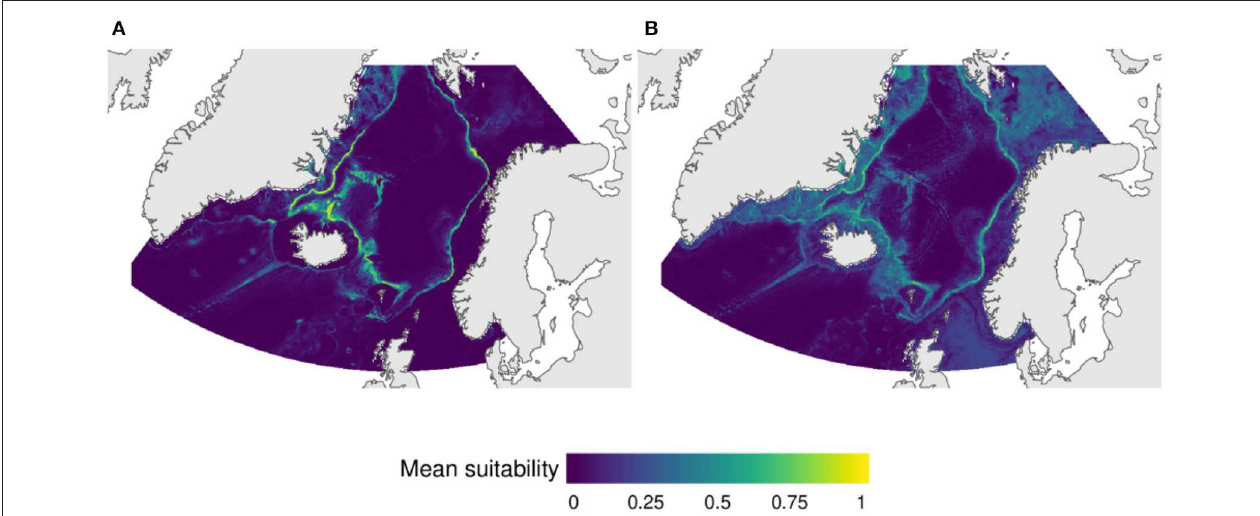
FIGURE 6 | Predicted distribution of VMEs based on a stacked species distribution model (SSMD) of (A) the deep-water sea pen Umbellula sp. and the carnivorous sponge Chrondocladia (C.) grandis , and (B) the cauliflower corals Duva florida , Drifa glomerata , and Gersemia sp., the sea pen Virgularia sp. and the carnivorous sponge Asconema sp.